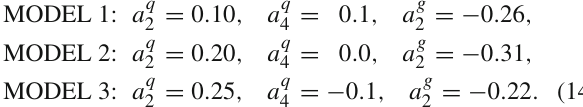
Fig. 1 The distribution of bins in the ( Q 2 numbers correspond to bins measured in [1]. Gray dashed lines corre- spond to extra binning during the generation of